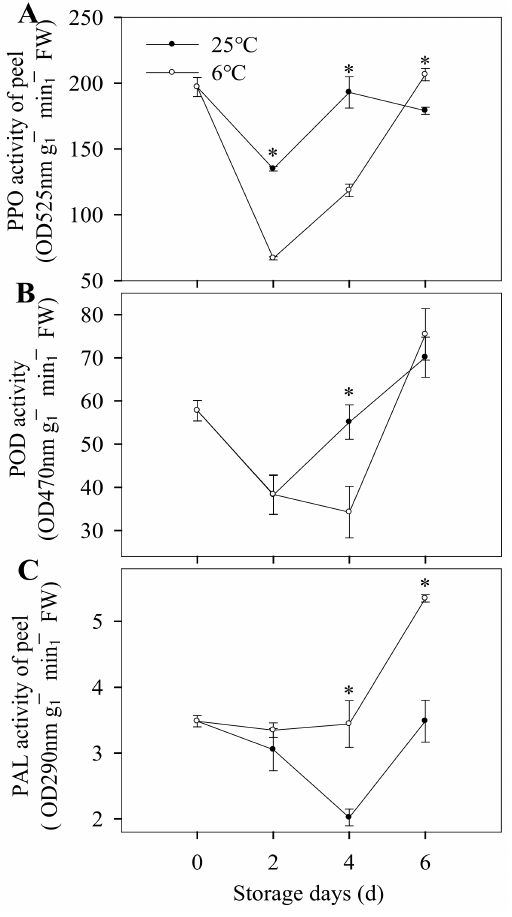
Figure 3. Changes in enzyme activity associated with browning of banana fruit during storage at 6 ◦ C and 25 ◦ C. PPO activity ( A ), POD activity ( B ), and PAL activity ( C ) of banana peel during storage. Each data point represents a mean ± standard error ( n = 3). ‘*’ means a significant difference between control and experimental fruit at the 5%